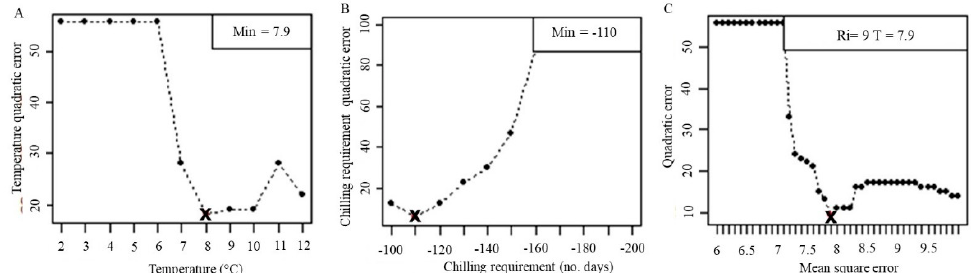
Figure 2. Output of the R script employed for the definition of the best values for the threshold temperature (TC) ( A ) and the chilling requirement (CR) ( B ) found by the iteration that minimizes the root mean square error (RI) ( C ), between predicted and observed number of days from the end of the previous season (harvest) to bud-burst (figures referred to ’Coscia’ cultivar). 149